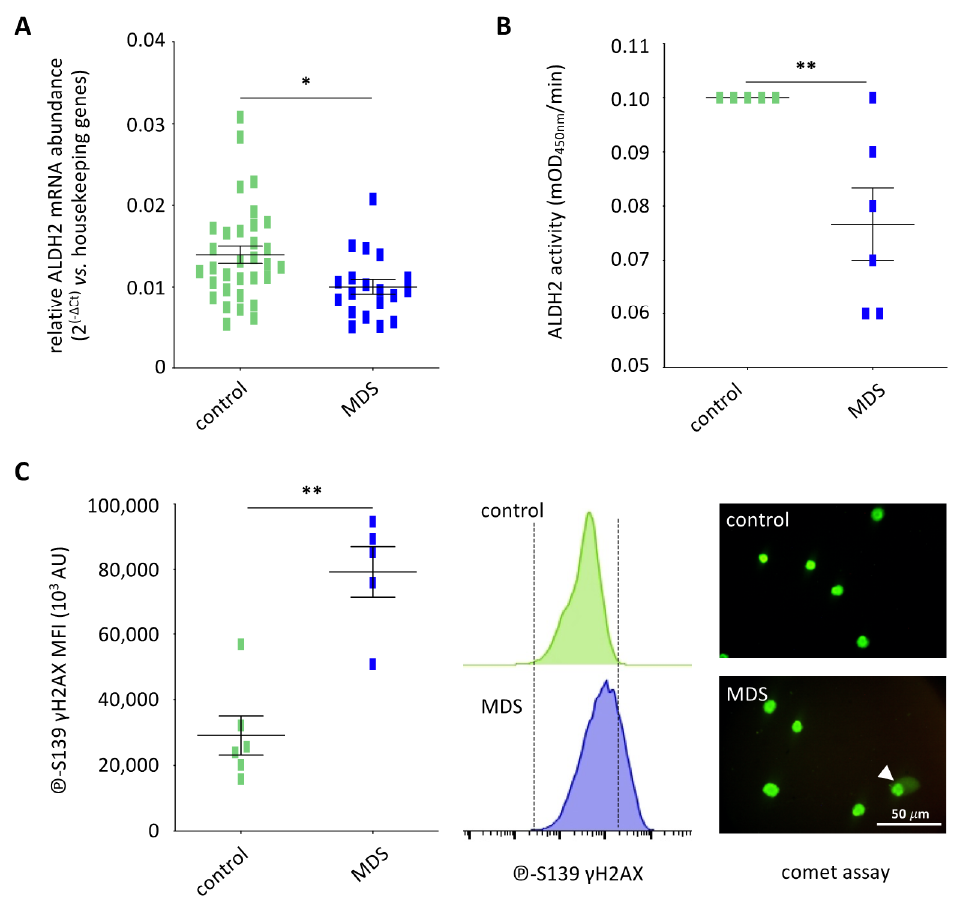
Figure 6. The ALDH2 pathway is altered in BM-MSCs from MDS patients. ( A ) ALDH2 expression is decreased in primitive MDS BM-MSCs, without in vitro exposure to pesticides (control BM-MSCs, n = 32; MDS BM-MSCs, n = 20). ( B ) ALDH2 activity is decreased in MDS BM-MSCs compared to control BM-MSCs ( n = 6). ( C ) ℗ -S139 γ H2AX quantification by flow cytometry shows increased double strand breaks in MDS BM-MSCs compared to normal BM-MSCs (left panel, n = 6), as shown in a representative experiment (middle panel). A representative experiment shows an increased nucleus DNA migration in MDS-BM-MSCs compared to control BM-MSCs by comet assays (right panel). Data are expressed as mean ± SEM; *, p < 0.05; Mann–Whitney test. Scalebar: 50 μ m.